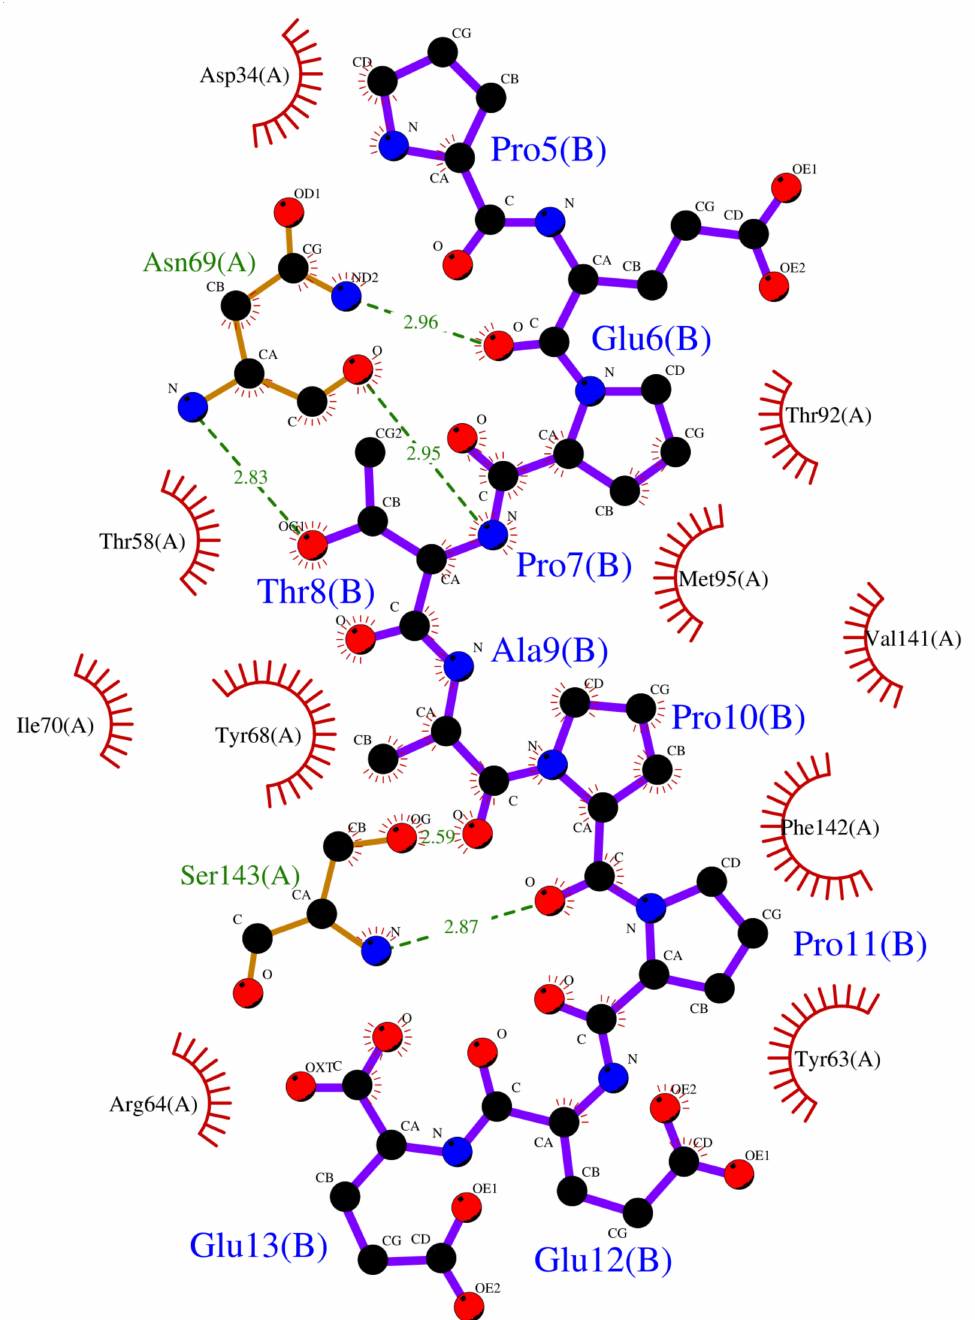
Figure 4. Overview of binding modes of the UEV domain proteins with the native linear